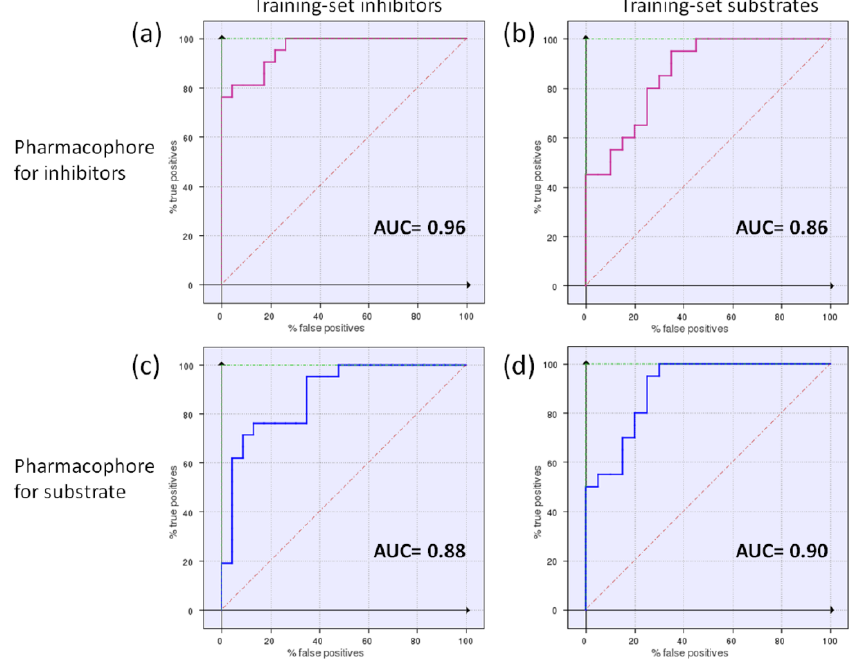
Figure 6. Enrichment plots (ROC curves) obtained by the cross-validation study. The pharmacophore model for inhibitors [9] ( a , b ) and the P2 model for substrates ( c , d ) were used to screen the datasets for inhibitors or substrates. AUC values are provided, according to the best descriptors for discrimination corresponding to each model: the Glob-Prod descriptor for the inhibitor pharmacophore [9] ( a , b ), and the H*O*H descriptor for the substrate pharmacophore ( c , d ).